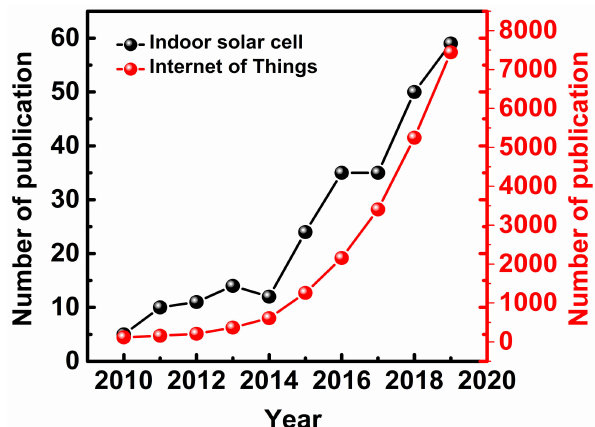
Figure 11. Number of publications on the topics named indoor solar cell and IoT per year (2010–2020) (Source: Web of